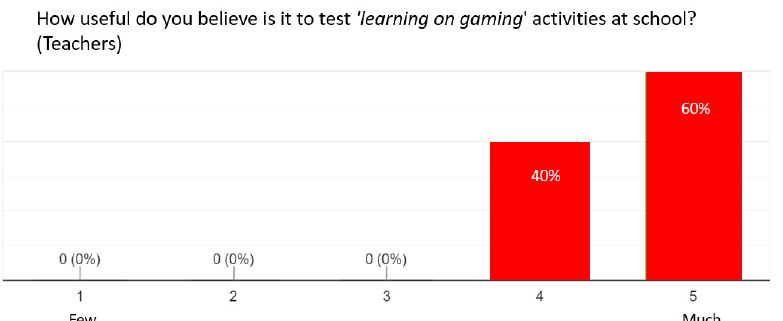
Figure 8. Cumulative values showing percentage of the feedback received for the second question from teachers and students, concerning all the played Salvina’s adventures.